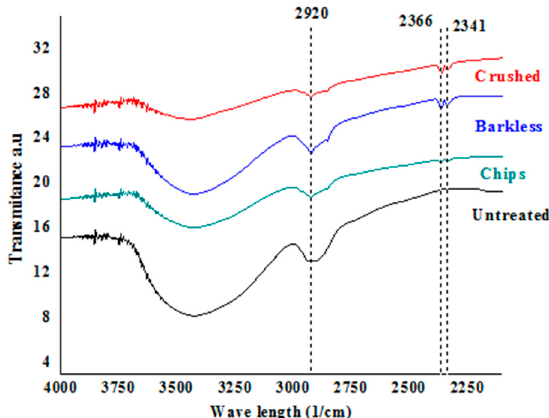
Figure 7. Fourier-transform infrared spectra in the 4000–2100 cm − 1 range of untreated and Ca(OH) 2 -treated G. angustifolia samples.